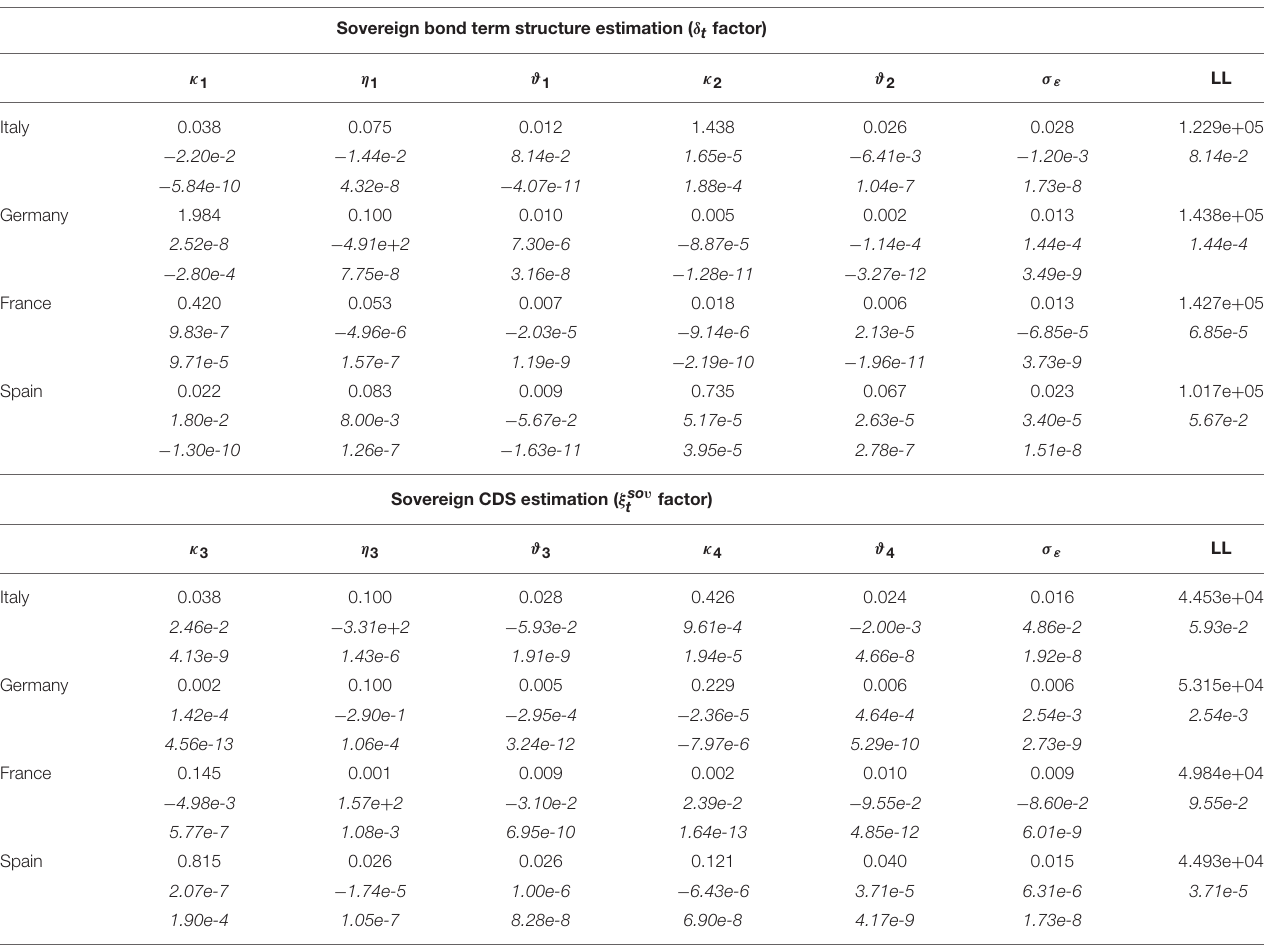
TABLE 6 | Estimated parameters of the multi-factor Vasicek